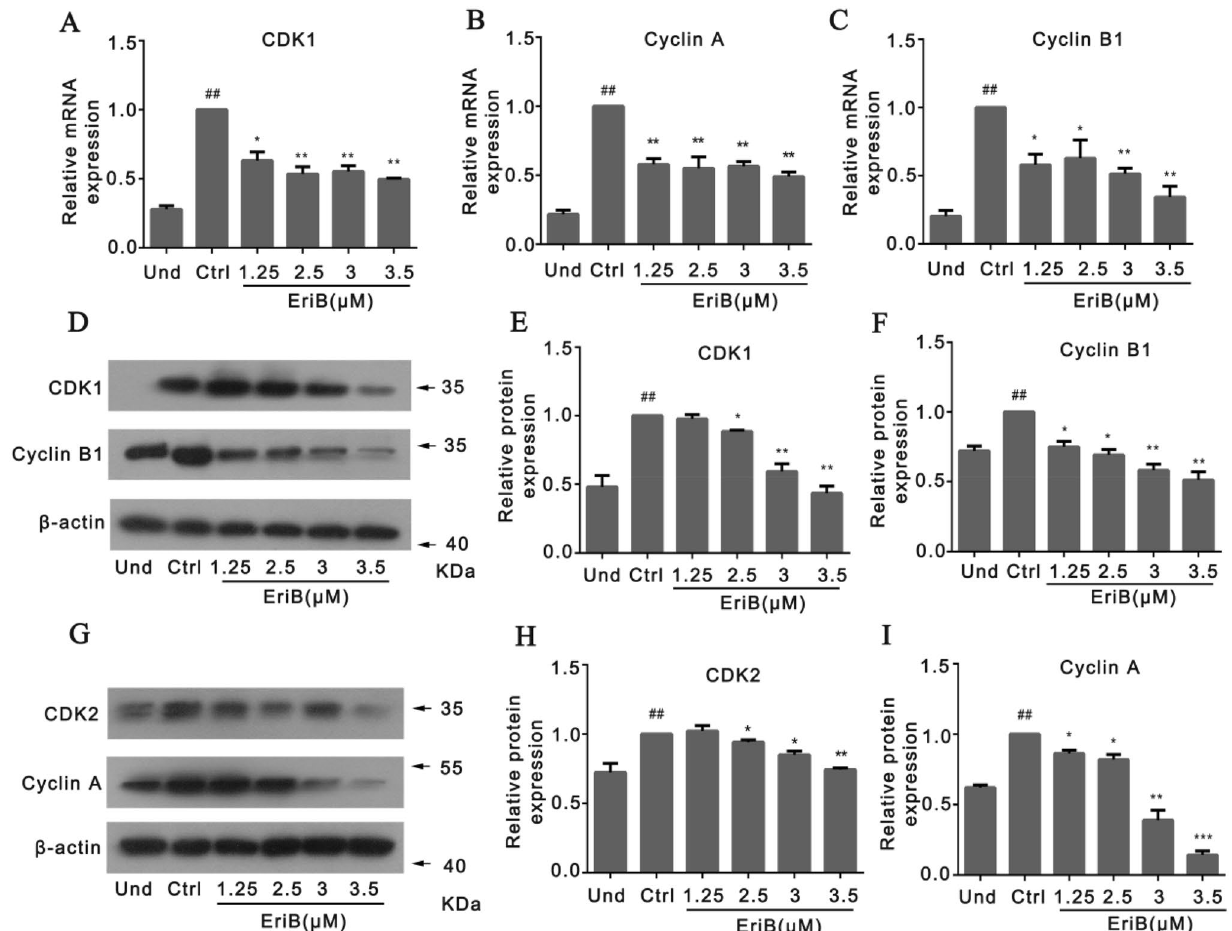
Fig. 5 Eriocalyxin B down-regulated the regulators for cells cycle. a-c The mRNA levels of CDK1, Cyclin A and Cyclin B1 of the cells treated by 2.5 μM eriocalyxin B for 24 h. d Western blotting of CDK1 and Cyclin B1 of the cells treated by eriocalyxin B for 24 h. e – f Normalized protein levels of samples in d for CDK1 and Cyclin B1